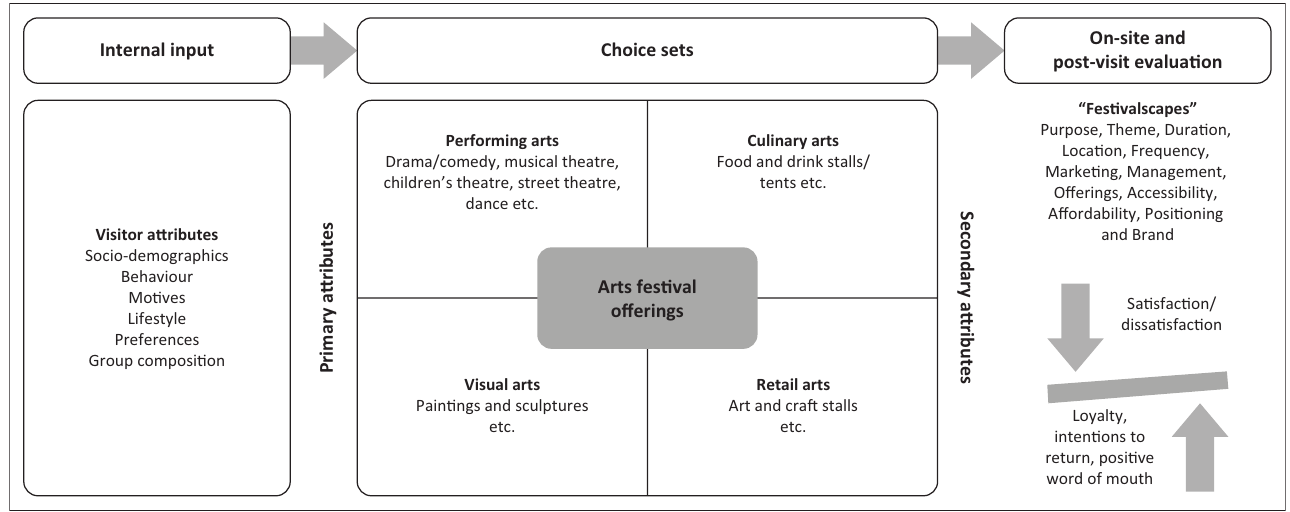
FIGURE 1: Conceptual framework for festival visitors’ decision-making